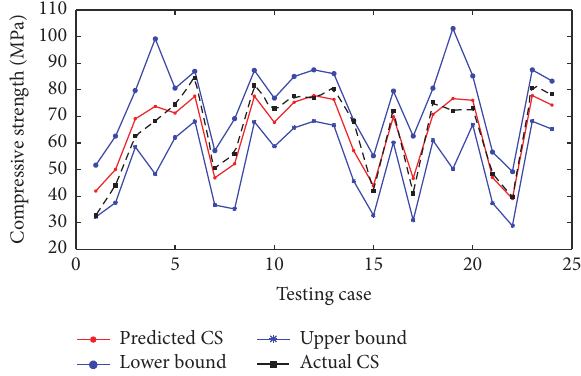
Figure 2: GPR prediction result with prediction